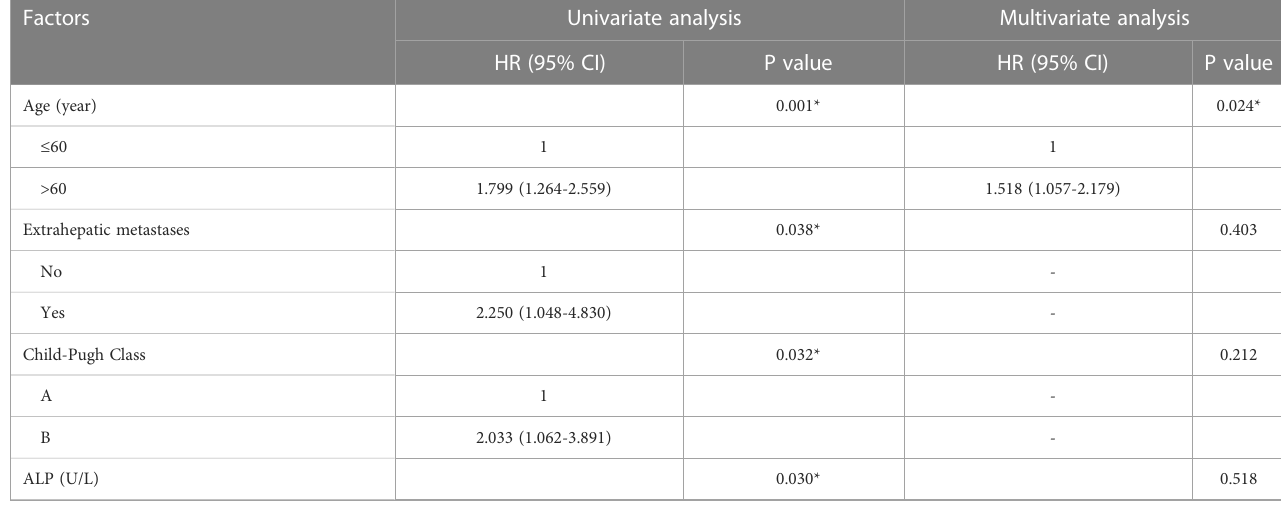
TABLE 5 Univariate and multivariate analysis of the prognostic factors for disease-free survival in the entire study population (N = 406). Factors Univariate analysis Multivariate analysis HR (95% CI) P value P